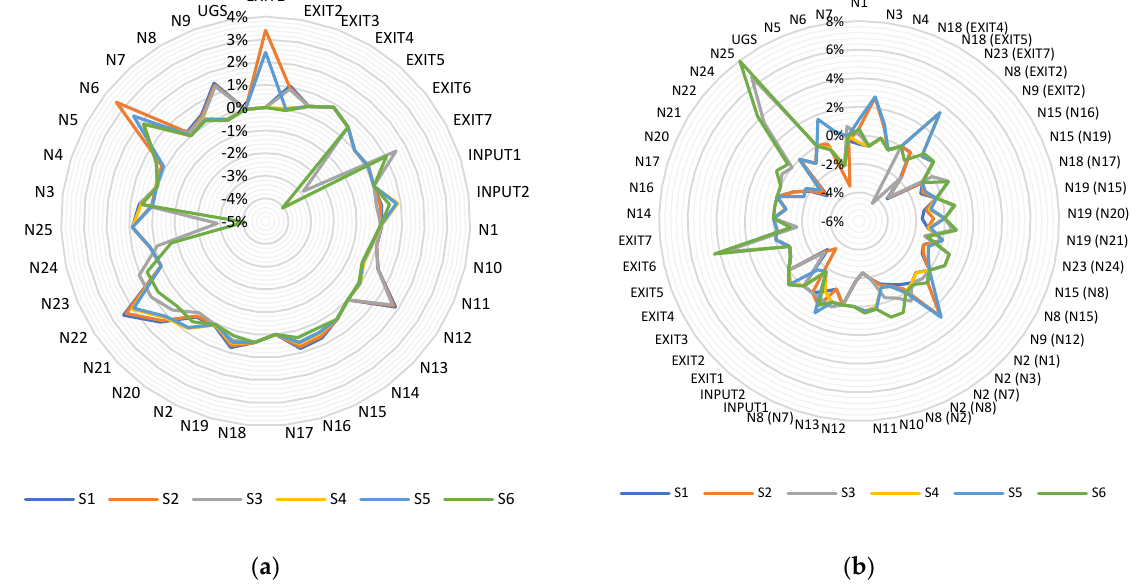
Figure 3. ( a ) Node gas pressure deviations; ( b ) branch volumetric gas flow deviations.